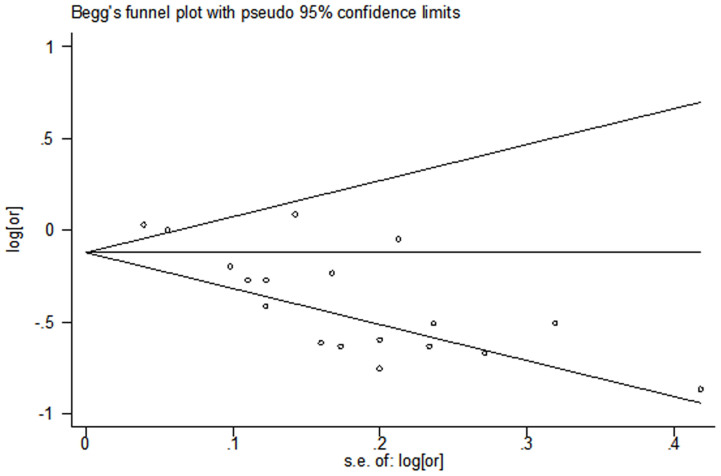
Begg's test of studies examining the association between maternal folate supplementation and the risk of CHDs.